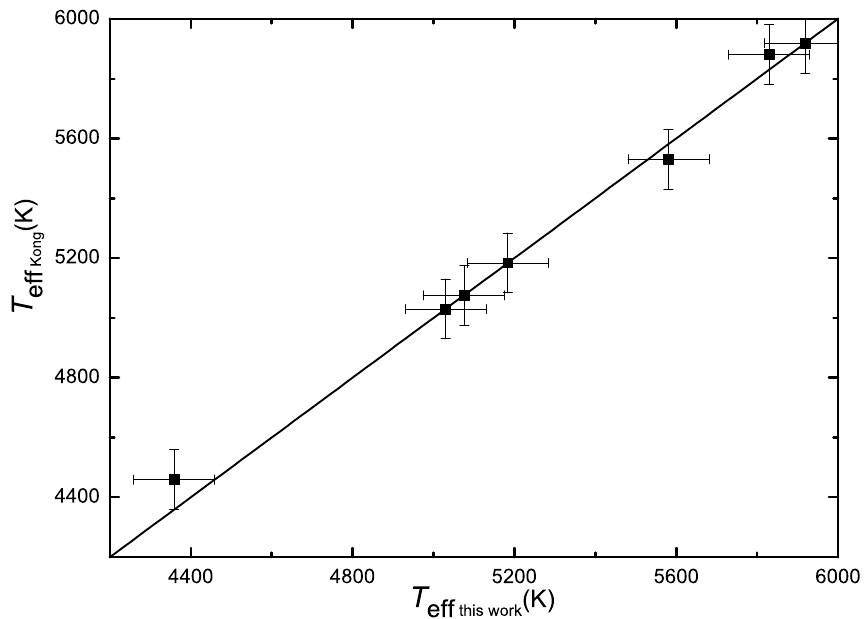
Figure 2. The comparison of the effective temperatures determined in this work with those of Kong et al. [24,37] for the sample